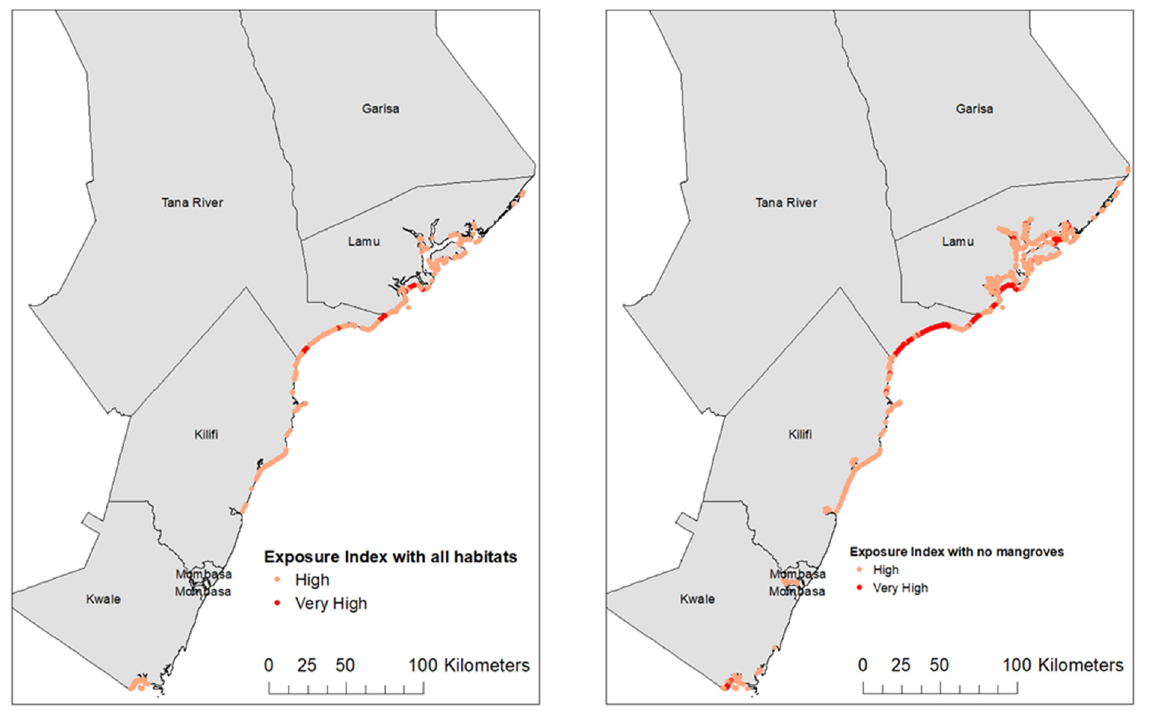
Figure 3. Location of high and very high exposure areas on the coast of Kenya resulting from InVEST model run with all habitats ( left ) and with no mangroves ( right ).